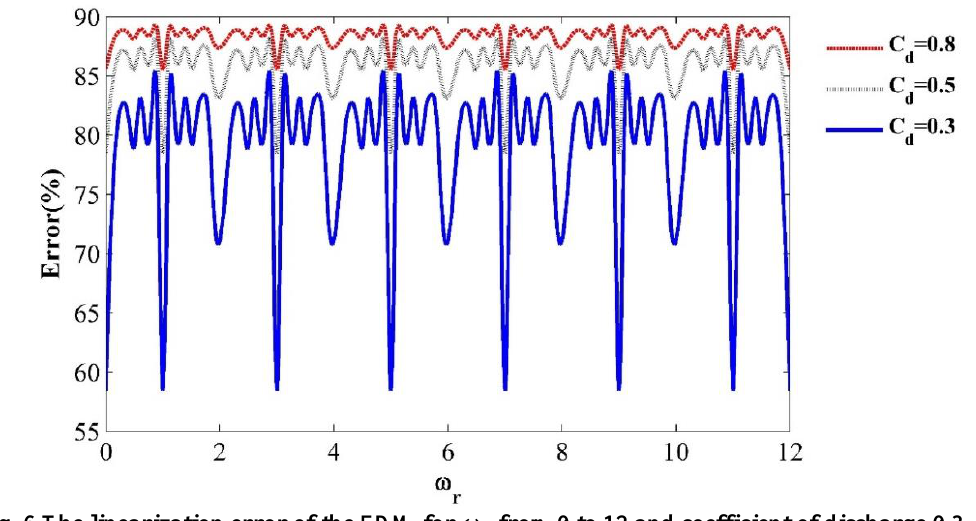
Fig. 6 The linearization error of the FDM for 𝝎